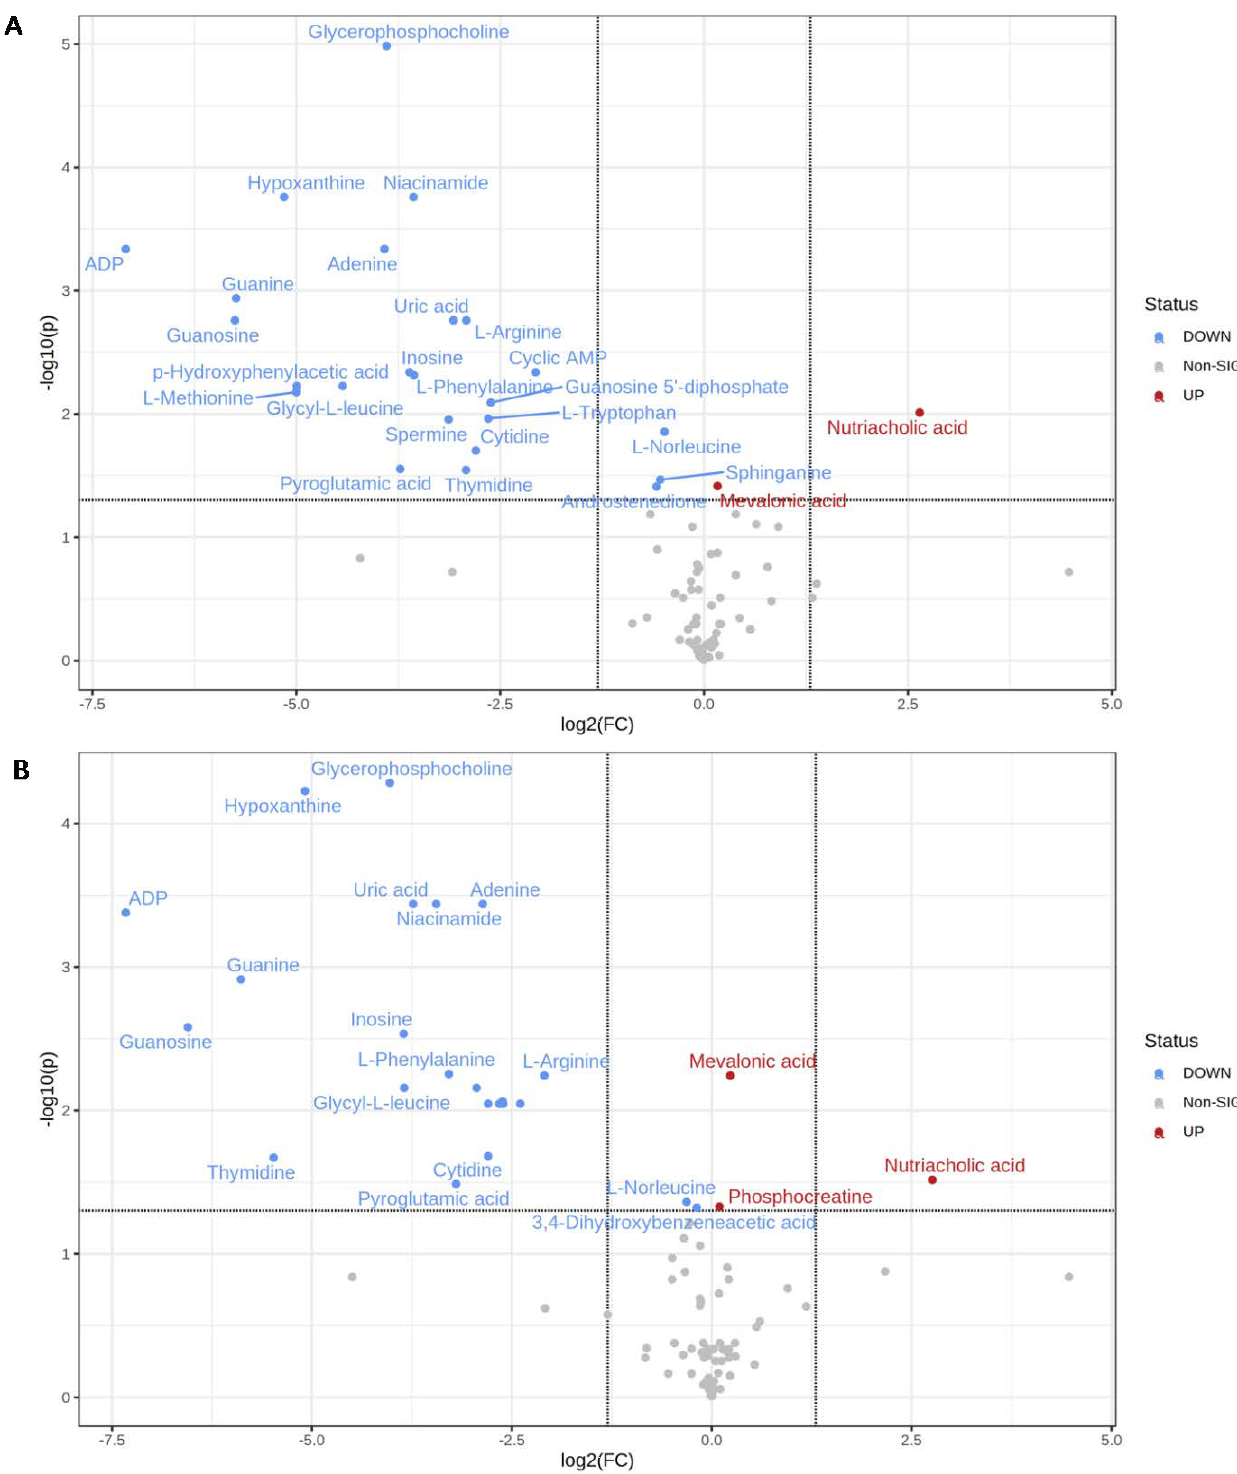
Figure 1. Volcano plots of U87 cells treated with ( A ) DMSO with paclitaxel 4.2 nM; ( B ) DMSO with (paclitaxel 4.2 nM and etoposide 10 µg/mL).